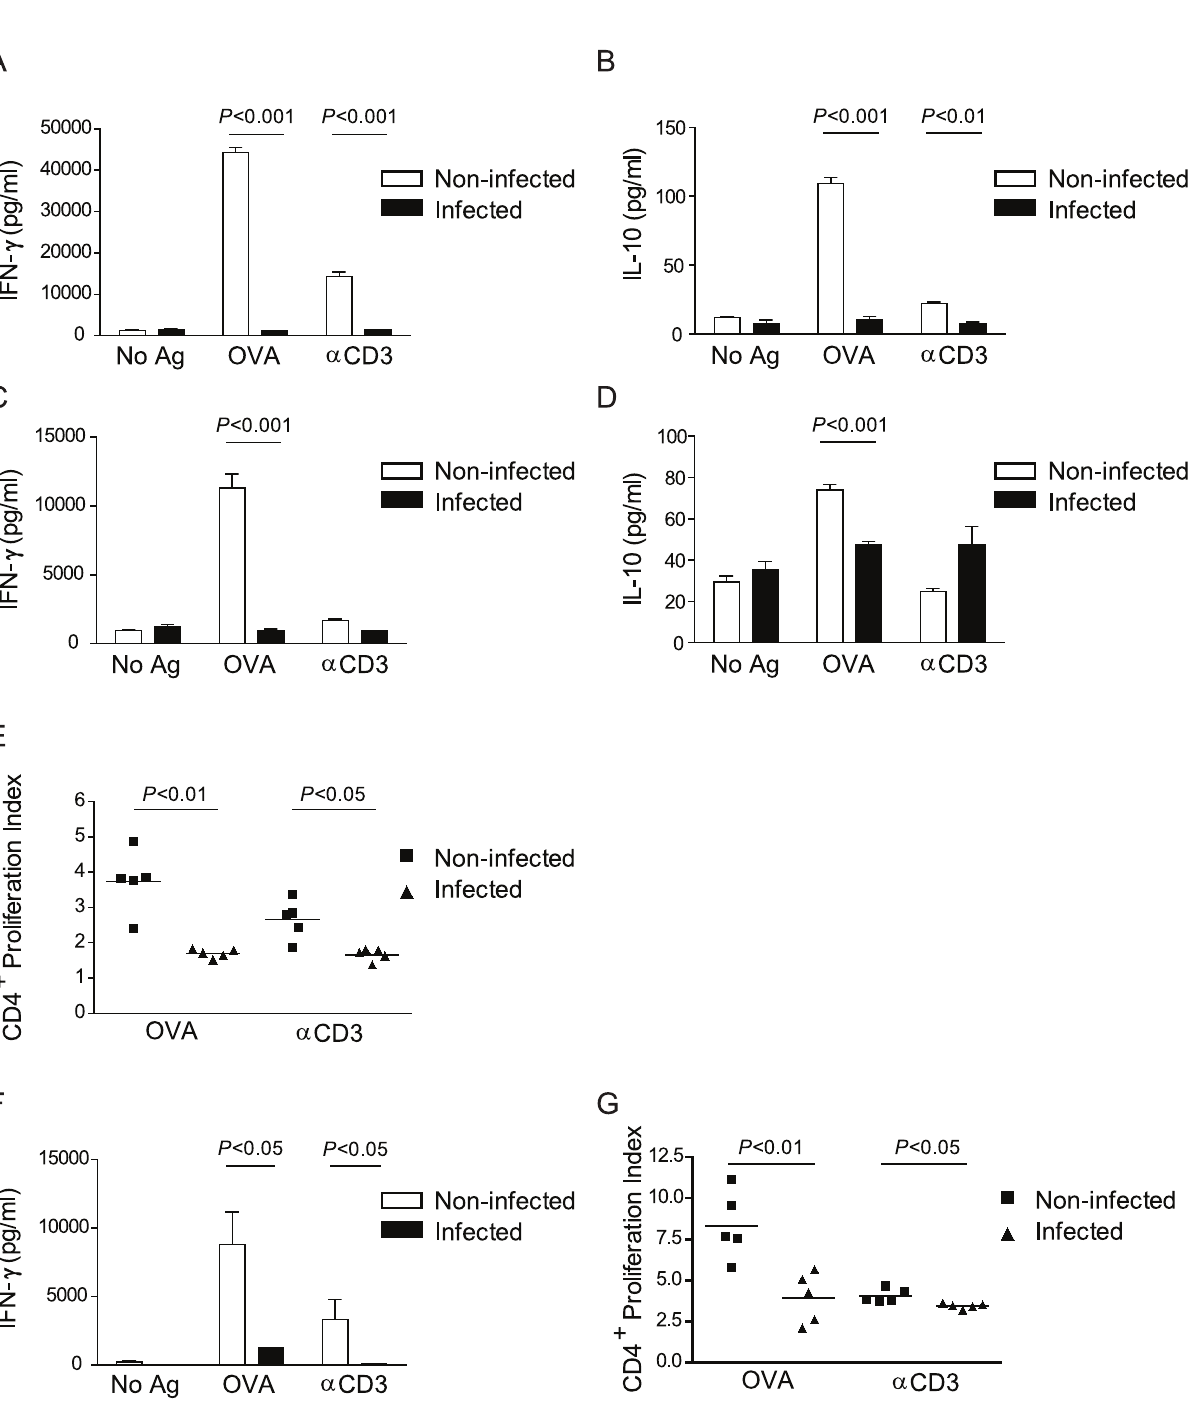
PLOS Neglected Tropical Diseases |